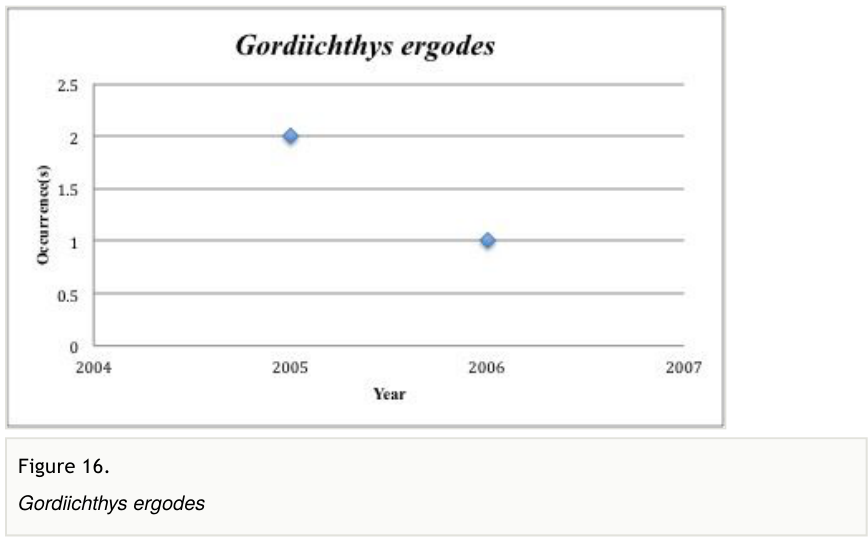
Figure 16. Gordiichthys